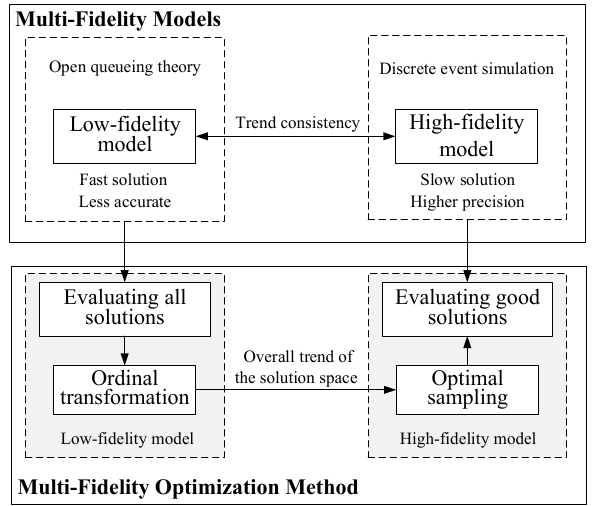
Fig. 2. The basic optimization framework of